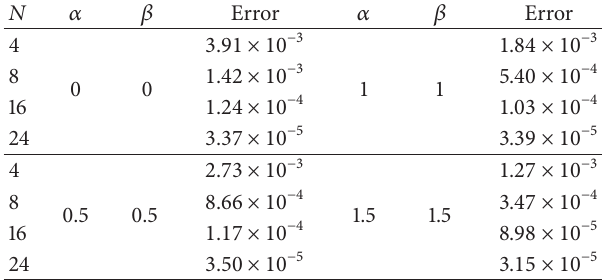
Table 1: Maximum absolute error for 𝜉 = 2.5, 𝜂 = 1.5 , and 𝜃 = 0.9 and different choices of 𝛼,𝛽 , and 𝑁